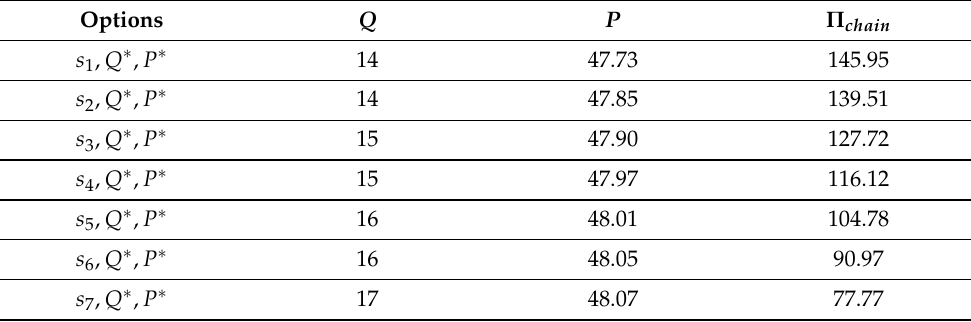
Figure 4. Centralized ( a , b ), Retailer ( c , d ), and Manufacturer ( e , f ). Table 3. Centralized supply chain optimum values for replenishment schemes.